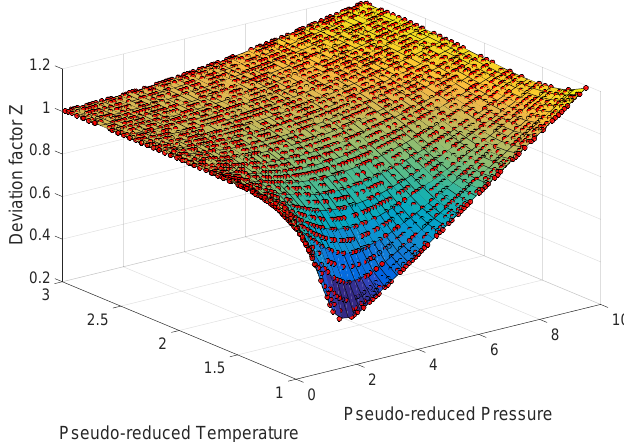
Figure 9. The Z factor surface generated by the TR-KRR model.